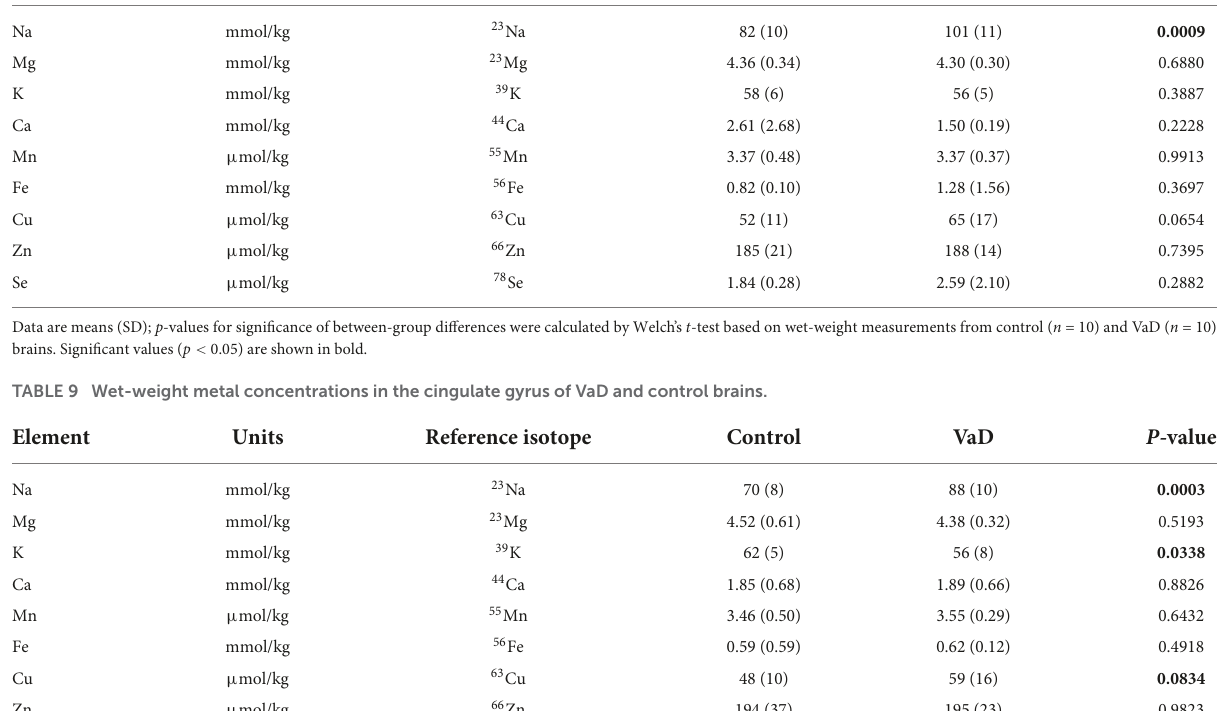
TABLE 8 Wet-weight metal concentrations in the frontal gyrus of VaD and control brains. Element Units Reference isotope